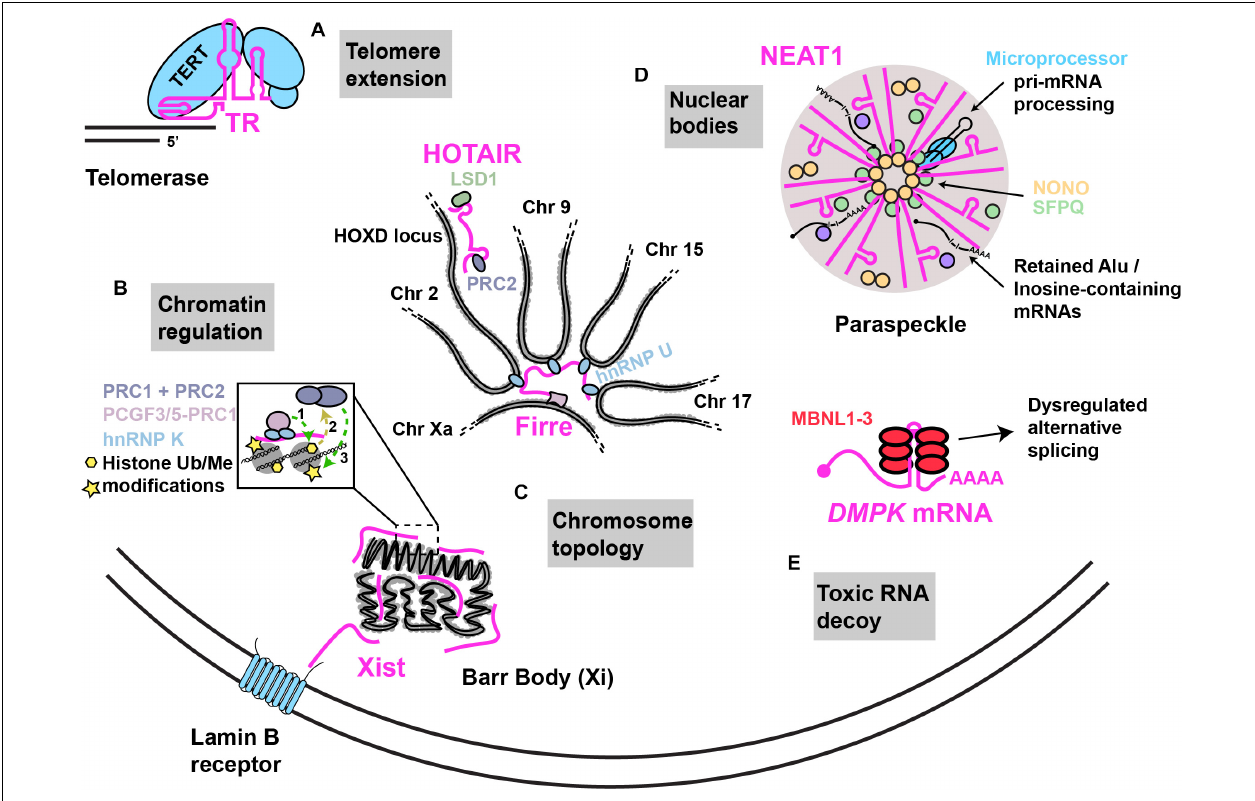
FIGURE 1 | Examples of nuclear RNA scaffolds and decoys. Scaffold and decoy RNAs are depicted in pink. (A) Telomere extension: the TR lncRNA scaffolds and provides the telomeric repeat template for the Telomerase complex that consists of the reverse transcriptase protein (TERT) along with other accessory proteins that function in telomere extension. (B) Chromatin regulation: Xist lncRNA establishes X chromosome inactivation by (1) hnRNP K initiated recruitment of; non-canonical PRC1 complex (Ub ligase) (2), whose activities recruit (3) canonical PRC1 and PRC2 (methyltransferases). HOTAIR recruits PRC2 and LSD1 (demethylase) to modify chromatin at numerous gene loci, including the HOXD locus. (C) Chromosome topology: (i) Firre lncRNA expressed from the active X chromosome, establishes chromosome territories by bringing together loci across multiple different chromosomes with the help of interaction with hnRNP U. (ii) Xist lncRNA can interact with the Lamin B receptor, resulting in recruitment of the inactivated X chromosome (“Barr body”) to the nuclear lamina. (D) Nuclear bodies: NEAT1–2 lncRNA acts as an RNA scaffold driving the assembly of nuclear paraspeckles via its interaction with NONO, SFPQ and several other proteins. NEAT1–2 facilitates NONO-Microprocessor interactions to aid in pri-miRNA processing. Paraspeckles also sequester Inosine-modified RNAs, preventing their export. (E) Toxic RNA decoy: CUG repeat expansions in the 3 (cid:48) UTR of DMPK sequester Muscleblind-like (MBNL) proteins, thus impairing alternative